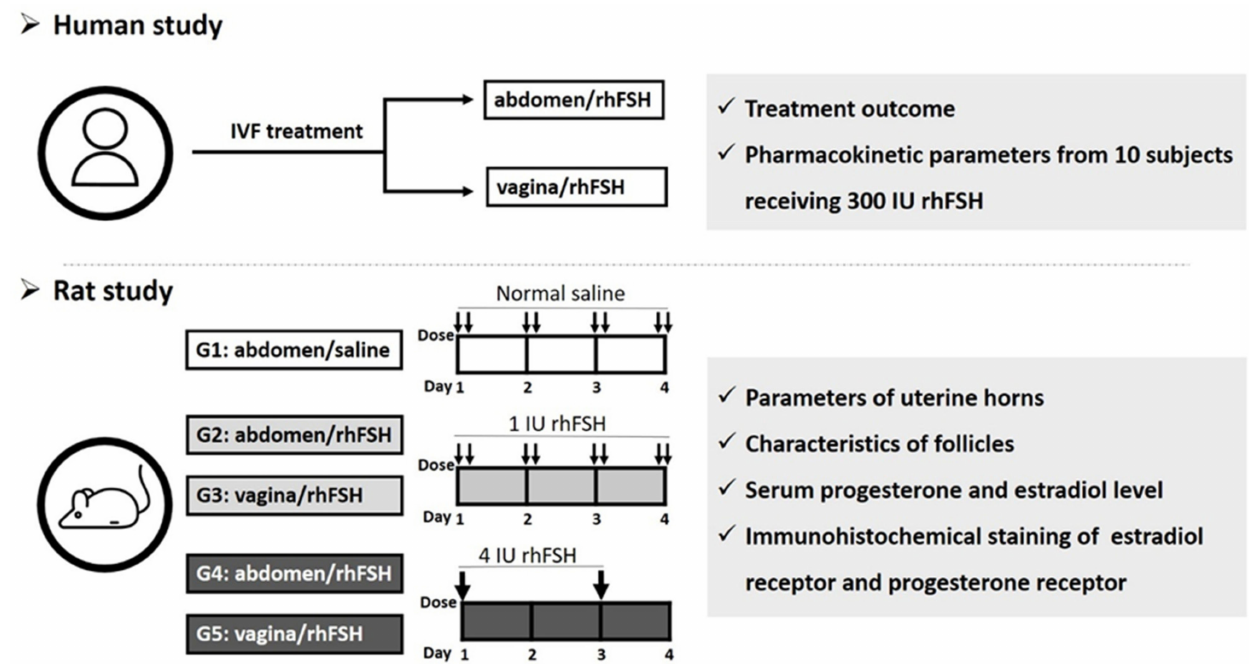
Figure 1. The overall scheme of study design. Abbreviations: rhFSH: recombinant human follicle-stimulating